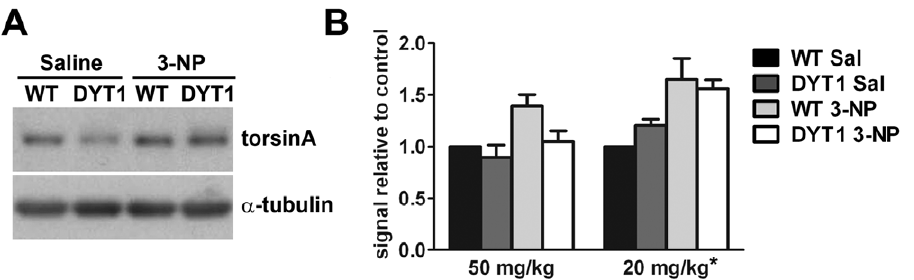
Figure 5. Levels of torsinA in the striatum are slightly increased upon treatment with 3-NP. (A) Representative western blot showing torsinA expression in striatal lysates of animals receiving 50 mg/kg/day of 3-NP or saline controls. (B) Quantification of torsinA expression as described in the text for animals that received 50 or 20 mg/kg/day of 3-NP (N: 5–7/group). ANOVA showed a non-significant trend in the 50 mg/kg/ day group (p=0.07) and significant differences in the 20 mg/kg/day group